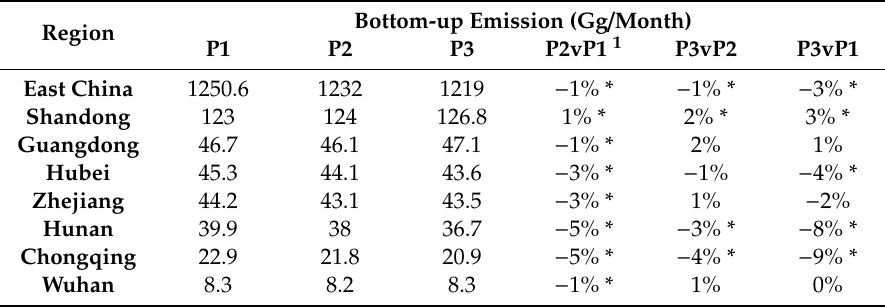
Figure A1. Domain setting of WRF- GC. Gray bordered grids represent the model grids of 27 × 27 km 2 resolution. Table A1. Averages of the bottom-up NOx emissions (MEIC, prepared for year 2017) during the three periods and relative changes between the three periods: P1 (January 1 to January 23), P2 (January 24 to February 9), and P3 (February 10 to March 12).